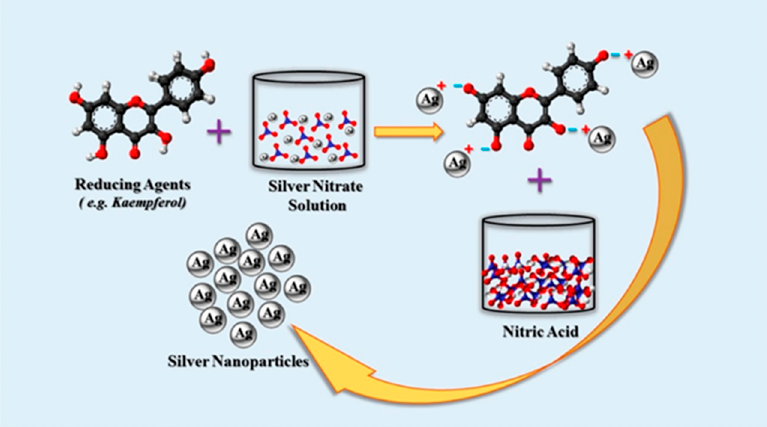
Figure 7. Plant-based synthesis of Ag-NPs by reaction of AgNO 3 with phytochemicals [47].